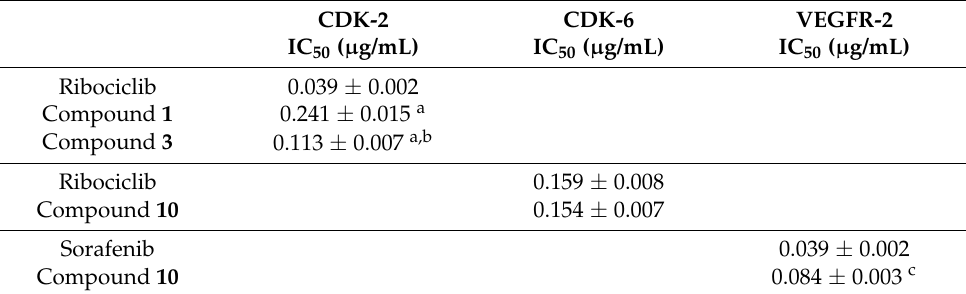
Table 3. The IC 50 of the most active cytotoxic compounds in µ g/mL.